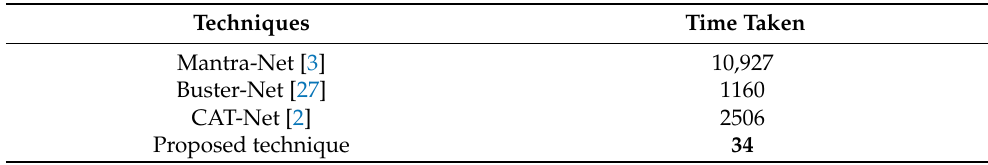
Figure 10. Average time taken by Mantra-Net [3], Buster-Net [27], CAT-Net [2], and the proposed technique to process the image for forgery detection. Table 3. Comparison of the time to process an image by the proposed technique with other techniques on CASIA 2.0 database (displayed values are in milliseconds).